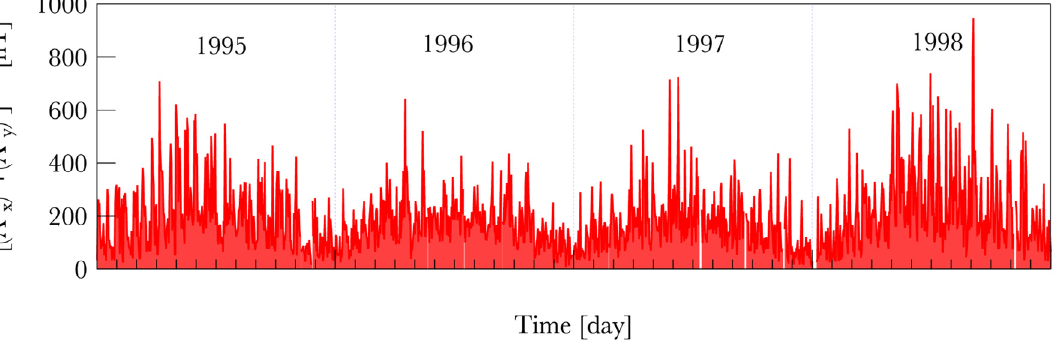
Figure 4. Temporal trend of the amplitude of the current vector associated with the first EOF in the case of CBB geomagnetic obser-